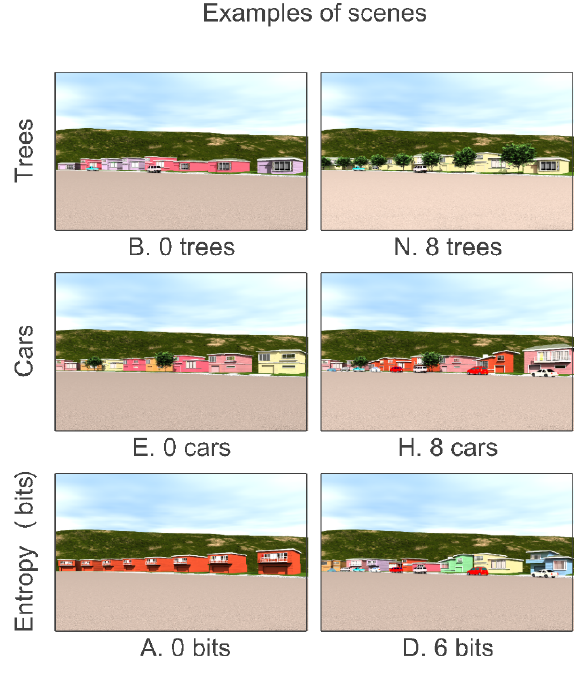
Figure 3. Design features and ranges of options for the Little Boxes